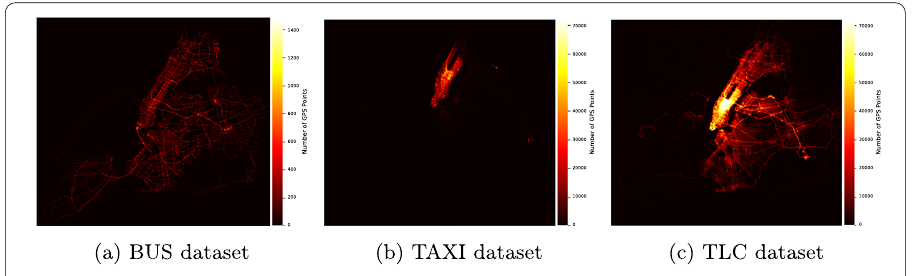
Fig. 1 Density plots of GPS points from three real-world